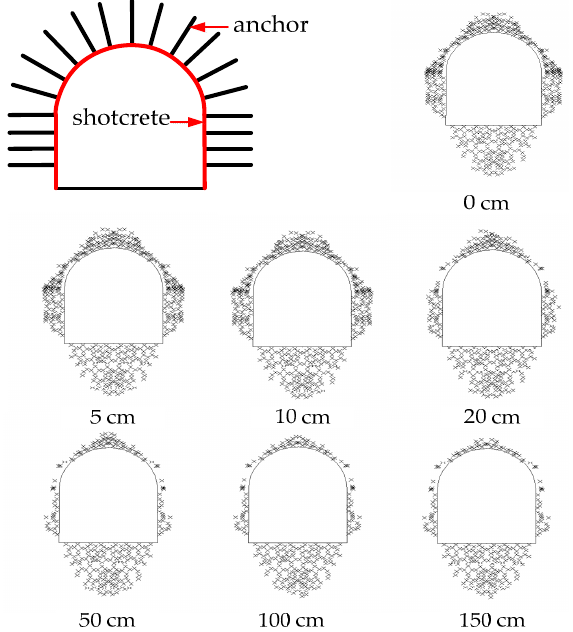
Appl. Sci. 2019 , 9 , x FOR PEER REVIEW Figure 13. Plastic zone in surrounding rock with different shotcrete thickness. Figure 13. Plastic zone in surrounding rock with di